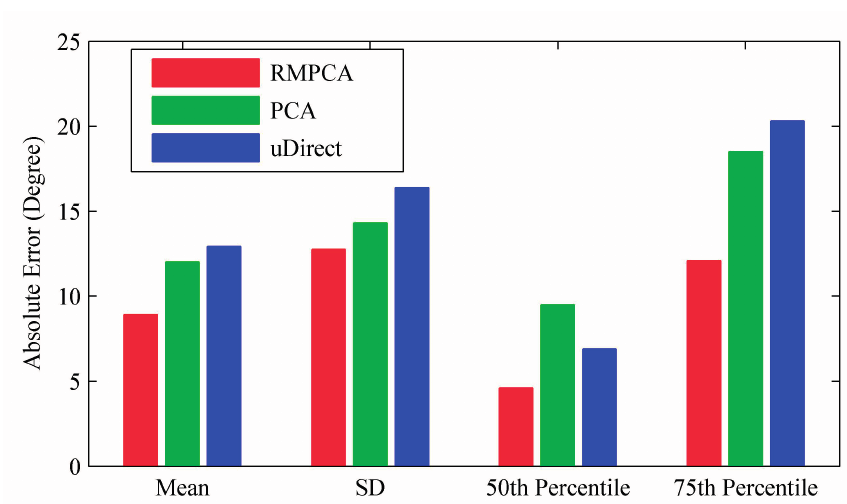
Figure 8. Performance comparisons of the absolute heading estimation error: mean, standard deviation (SD), 50th percentile and 75th percentile.